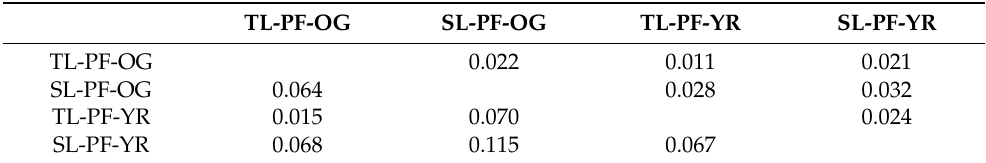
Table 4. Pairwise F ST estimates (above diagonal) and genetic distances (below diagonal) among the four populations.